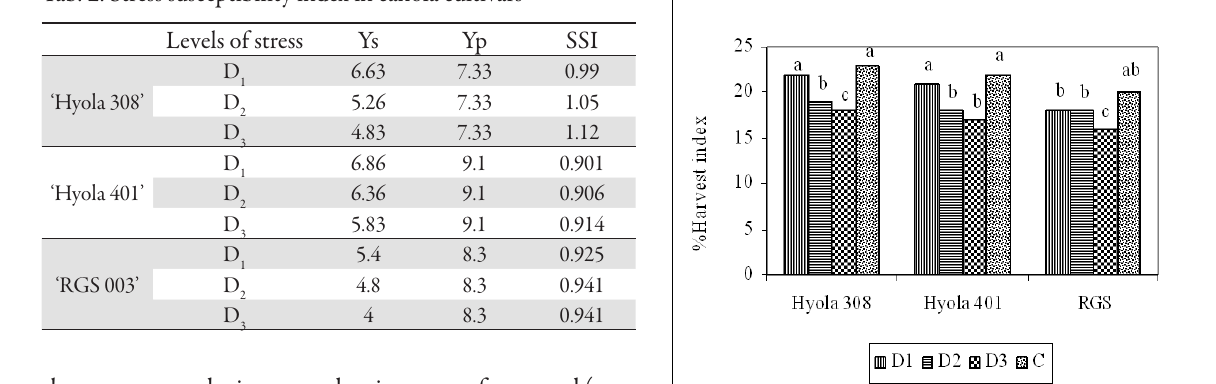
Tab. 3. Correlation between dry matter, economic yield, biological yield, oil yields, harvest index and stress susceptibility index (SSI) characteristics in the first level of stress (stress in the beginning stage of stem elongation to early flowering, D